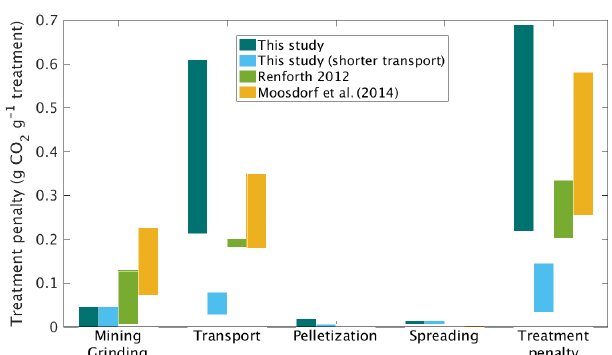
Figure 4. Carbon penalties for the wollastonite treatment. Carbon penalties for logistic elements of the treatment are compared with literature estimates for large-scale roll-out of enhanced rock weath- ering for the HBEF treatment (3.44tha − 1 ), with and without long- distance transport for